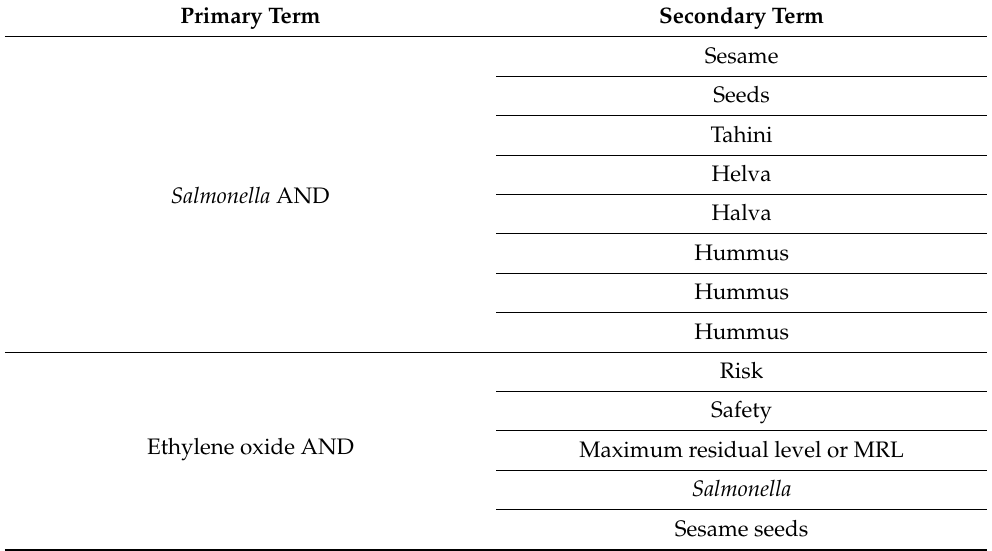
Table 3. Key search terms in the